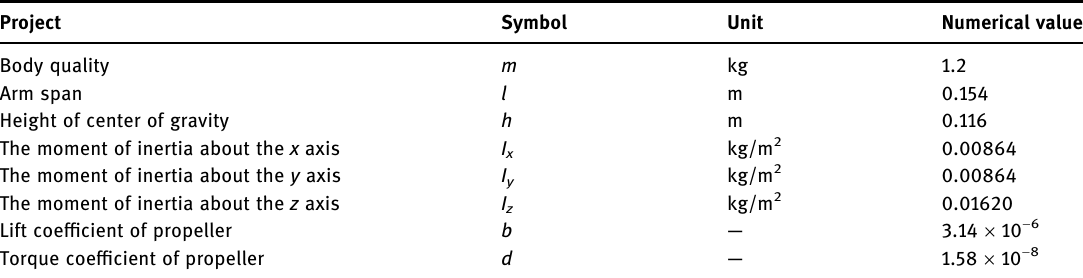
Table 1: PID and quaternion control parameters